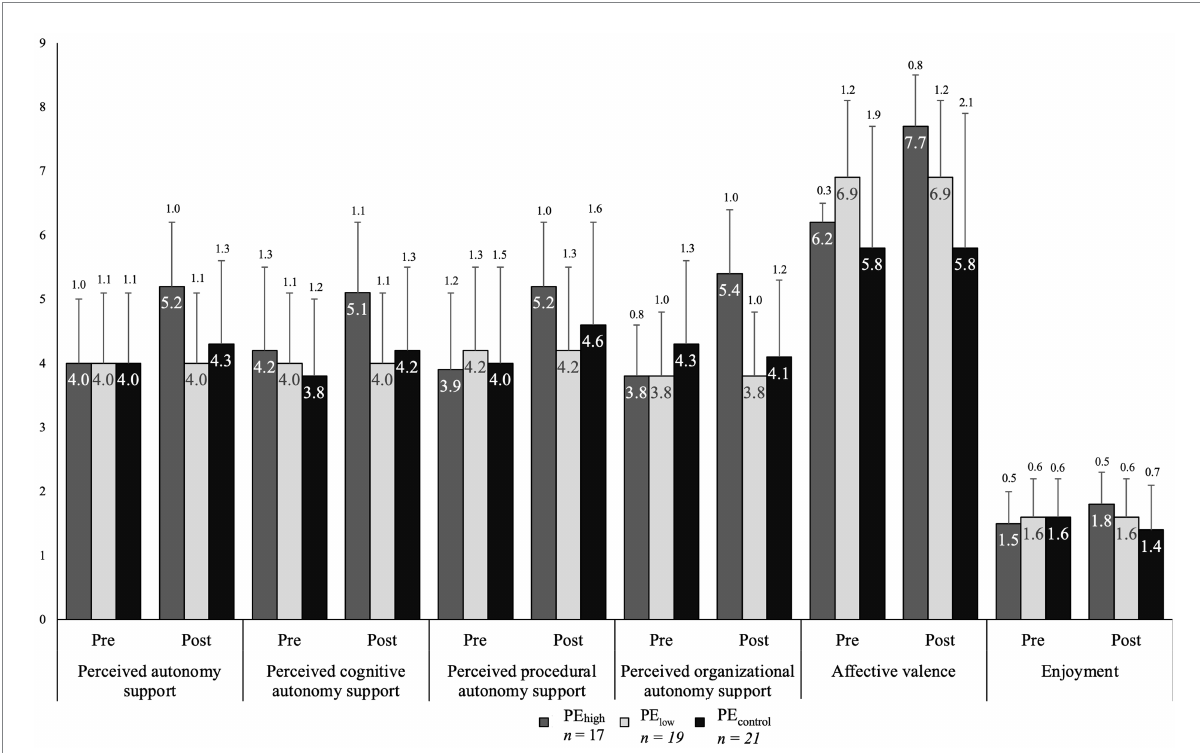
FIGURE 4 Descriptive mean comparisons (columns) with standard deviations (whiskers) of perceived autonomy support, cognitive autonomy, procedural autonomy, and organizational autonomy as well as affective valence and enjoyment in the three different PE classes (PE high , PE low , PE control ) at pre- and post-measurement.